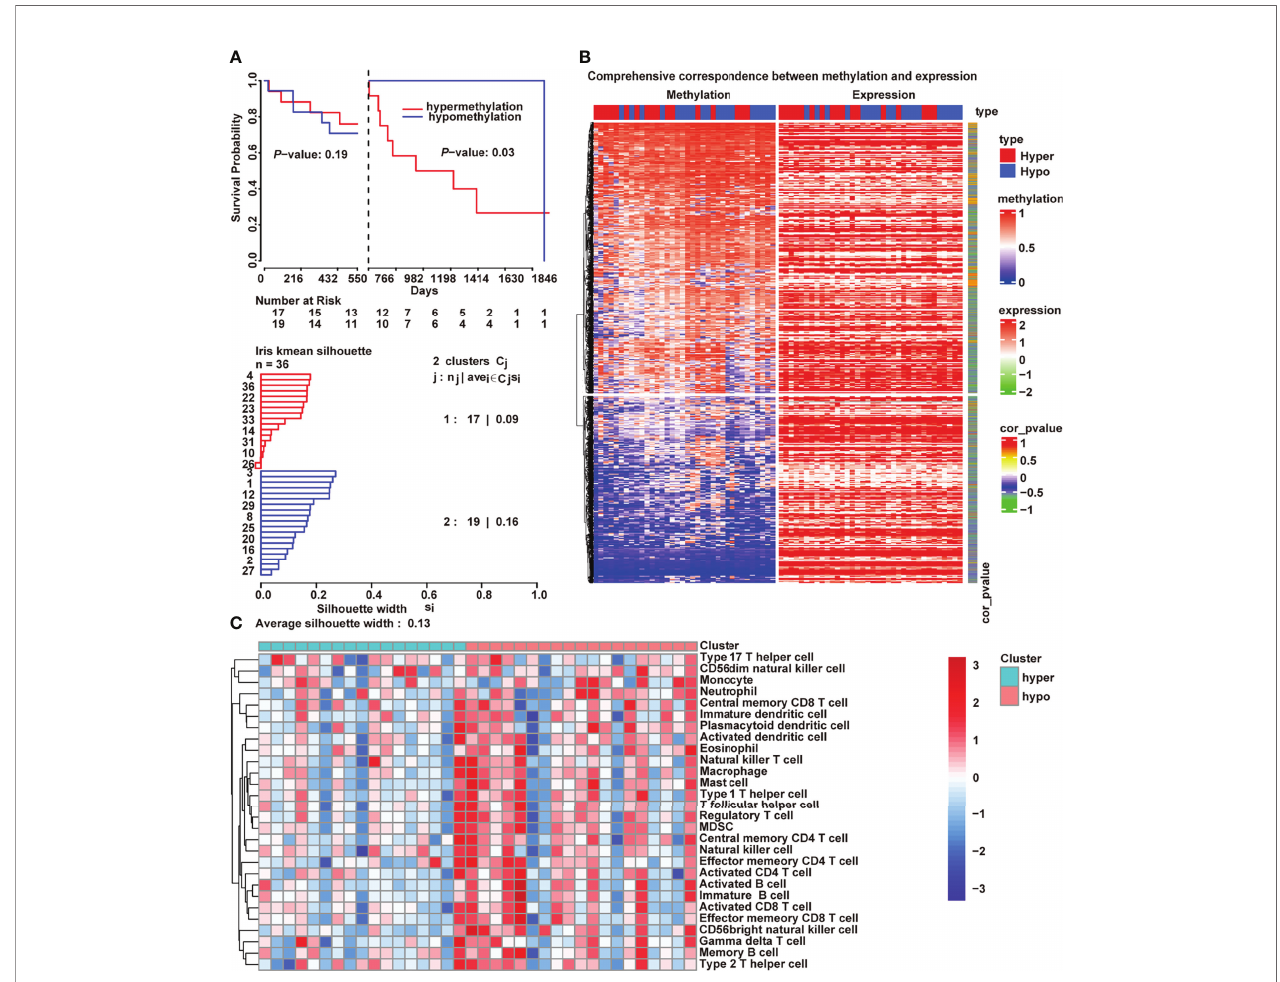
FIGURE 2 | DNA methylation-regulated tumor immunity in cholangiocarcinoma. (A) Kaplan – Meier curves of the association of DNA methylation with overall survival; (B) Correlation between transcriptome and methylation; (C) Differences of 28 immune cells between hypermethylation and